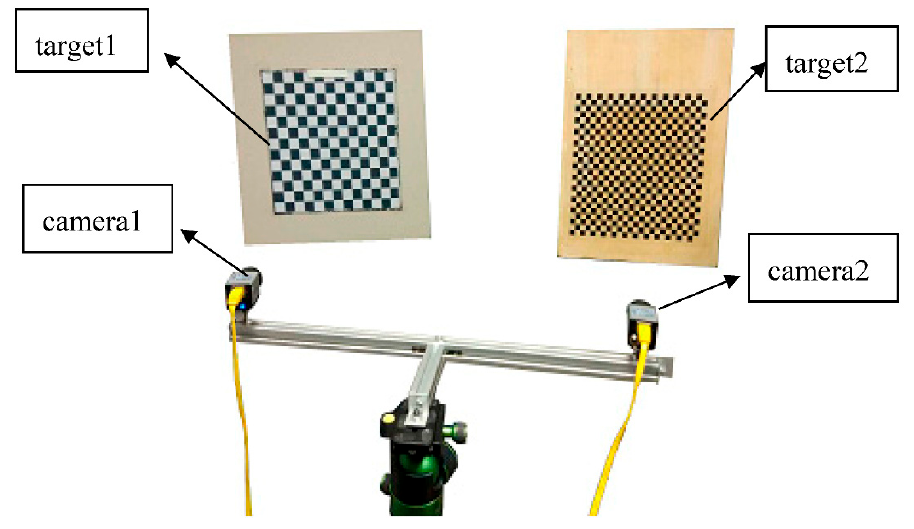
Figure 5. The two cameras experimental setup.